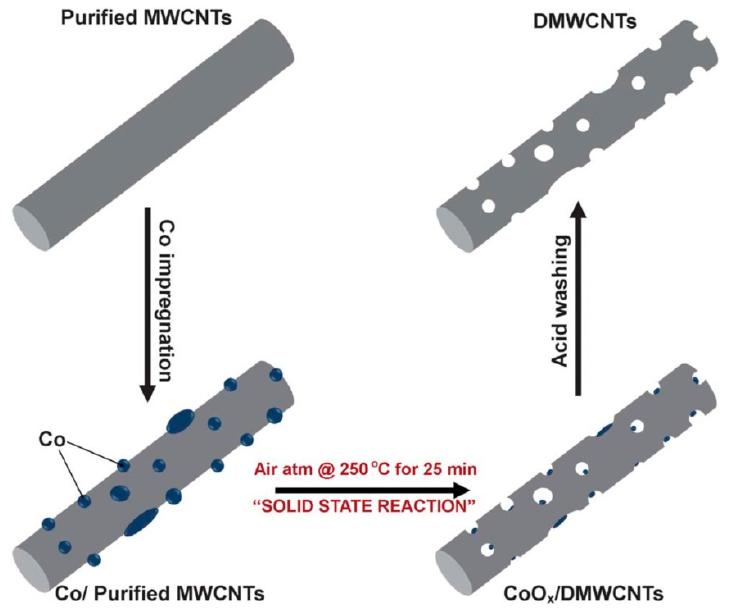
Figure 6. Schematic structure and procedure of preparing drilled multiwalled carbon nanotubes (DMWCNTs) from multiwalled carbon nanotubes (MWCNTs) Republished with permission from the Royal Society of Chemistry, from [90]; permission conveyed through Copyright Clearance Center, Inc. (Danvers, MA,